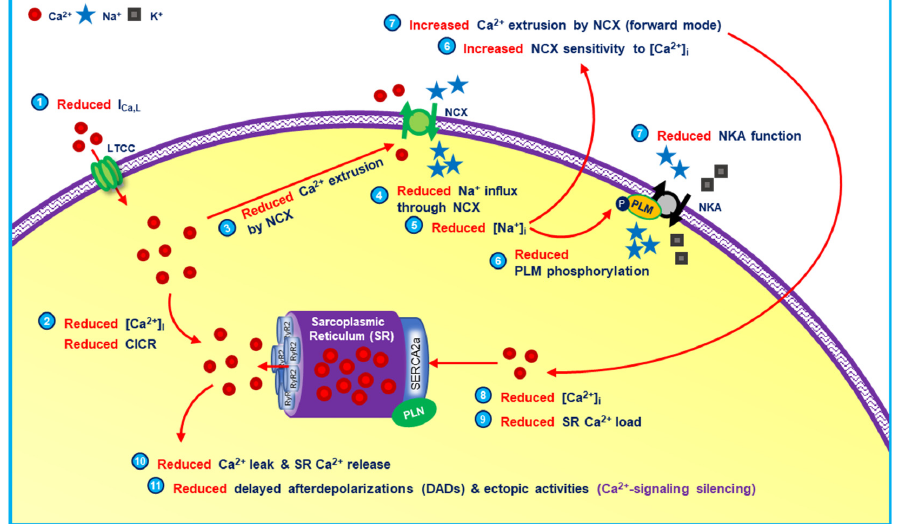
Figure 2. The proposed mechanisms involved in low intracellular sodium-induced calcium silenc- ing. The reduction of LTCC function following rapid atrial pacing/persistent AF has been proposed as the cause of low intracellular sodium, which further induced the calcium extrusion via NCX and lowered the frequency of SR calcium leak and SCaEs, ultimately leading to calcium-signaling stabi- lization/silencing in the long term. (CICR = calcium-induced calcium release; I Ca,L = L-type calcium current; LTCC = L-type calcium channel; NCX = sodium-calcium exchanger; NKA = sodium-potas- sium adenosine triphosphatase; PLM = phospholemman; PLN = phospholamban; RyR2 = ryanodine receptor type 2; SERCA2a = sarco/endoplasmic reticulum calcium adenosine triphosphatase-2a).